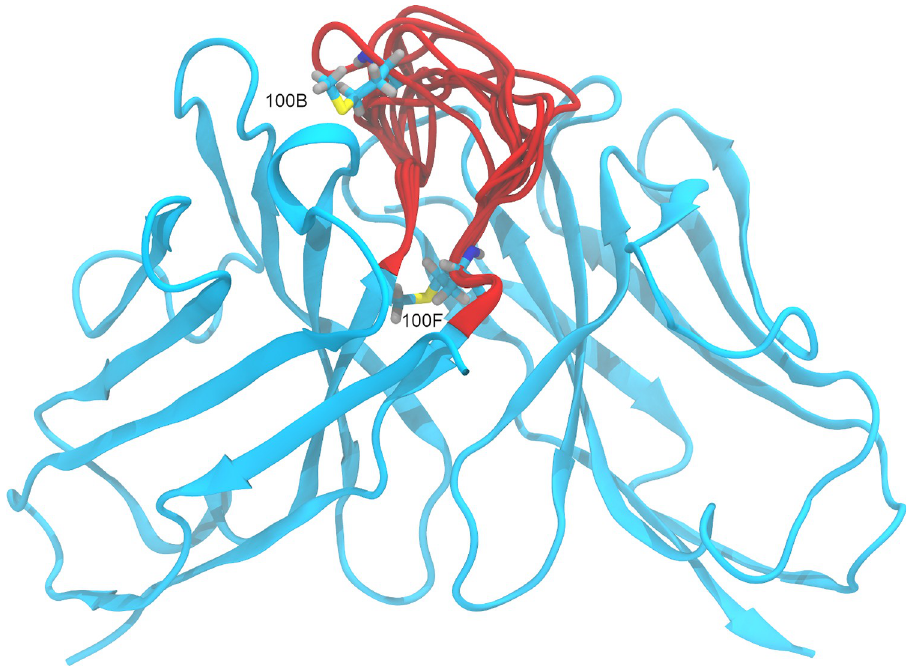
Fig 4. Three-dimensional structure (homology model) of the Fv region of the antibody Vesencumab. Methionines 100B and 100F, located in the H3 loop, are shown with carbon atoms colored in cyan, oxygen in red, hydrogen in gray, nitrogen in blue and sulfur in yellow. The conformations of the H3 loop obtained with Prime are represented in red.